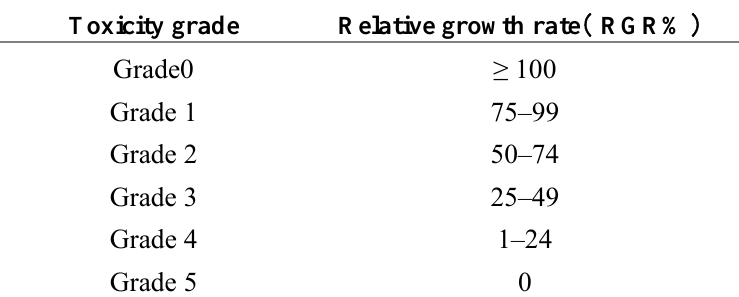
Table 3 ． The table of RGR and toxicity